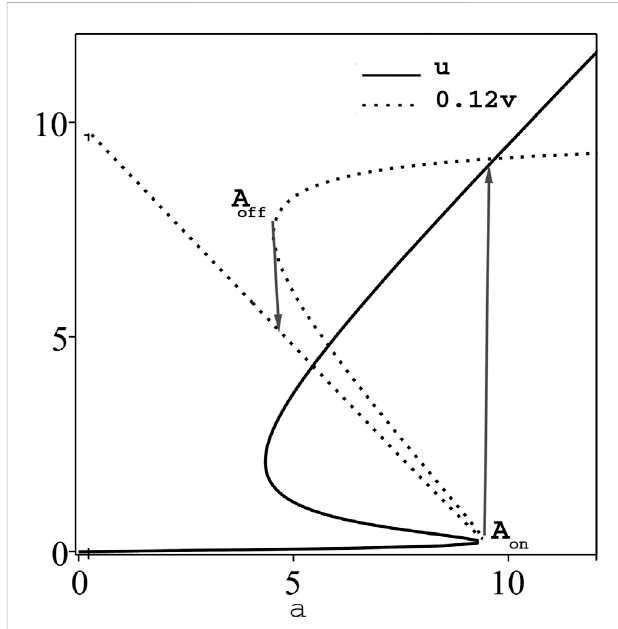
FIGURE 7 The steady state bistable curves, u and 0.12 v , versus the control parameter, a , for fi xed parameters K =20, B =100, γ = l =1.